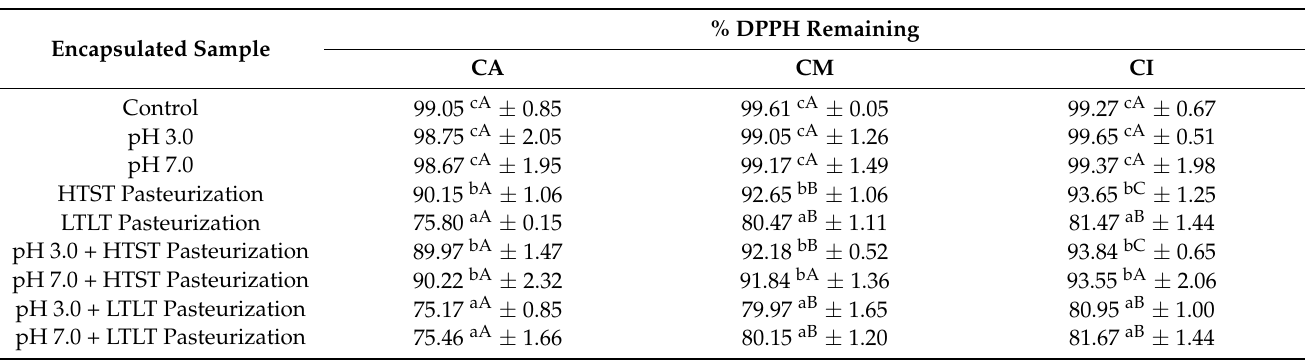
Table 8. % DPPH remaining of alginate, alginate/maltodextrin, and alginate/inulin hydrogel beads containing encapsulated antioxidant crude extract from CSCG after simulated food process condi-